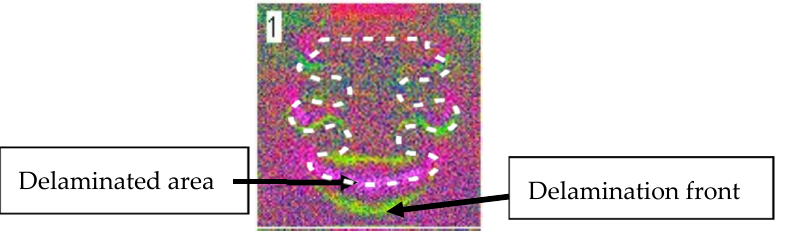
Figure 12. Differentiation between delaminated area and delamination front in Lock-In thermogra- phy.